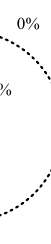
Figure 1. A typical 0-1 perception model diagram.